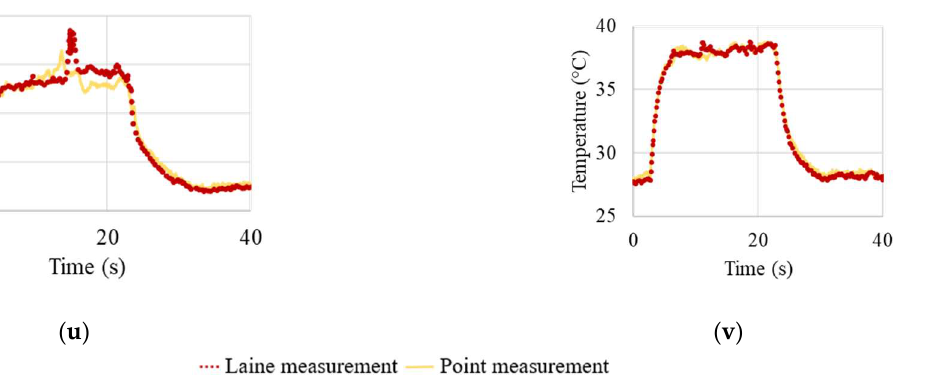
Figure A2. Temperature waveforms of the measurements at different heating currents: ( a ) 410 mA; ( b ) 400 mA; ( c ) 390 mA; ( d ) 380 mA; ( e ) 370 mA; ( f ) 360 mA; ( g ) 350 mA; ( h ) 340 mA; ( i ) 330 mA; ( j ) 320 mA; ( k ) 310 mA; ( l ) 300 mA; ( m ) 290 mA; ( n ) 280 mA; ( o ) 270 mA; ( p ) 260 mA; ( q ) 250 mA; ( r ) 240 mA; ( s ) 230 mA; ( t ) 220 mA; ( u ) 210 mA; ( v ) 200 mA. Sample diameter, 150 μm.